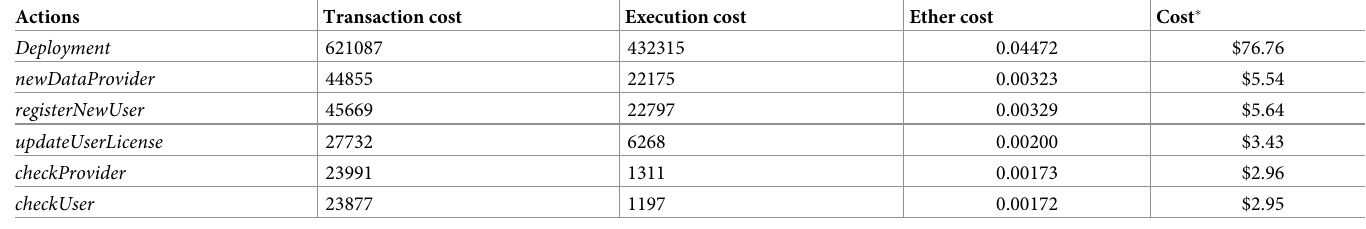
Table 4. Cost listing of all functions of the LUCE